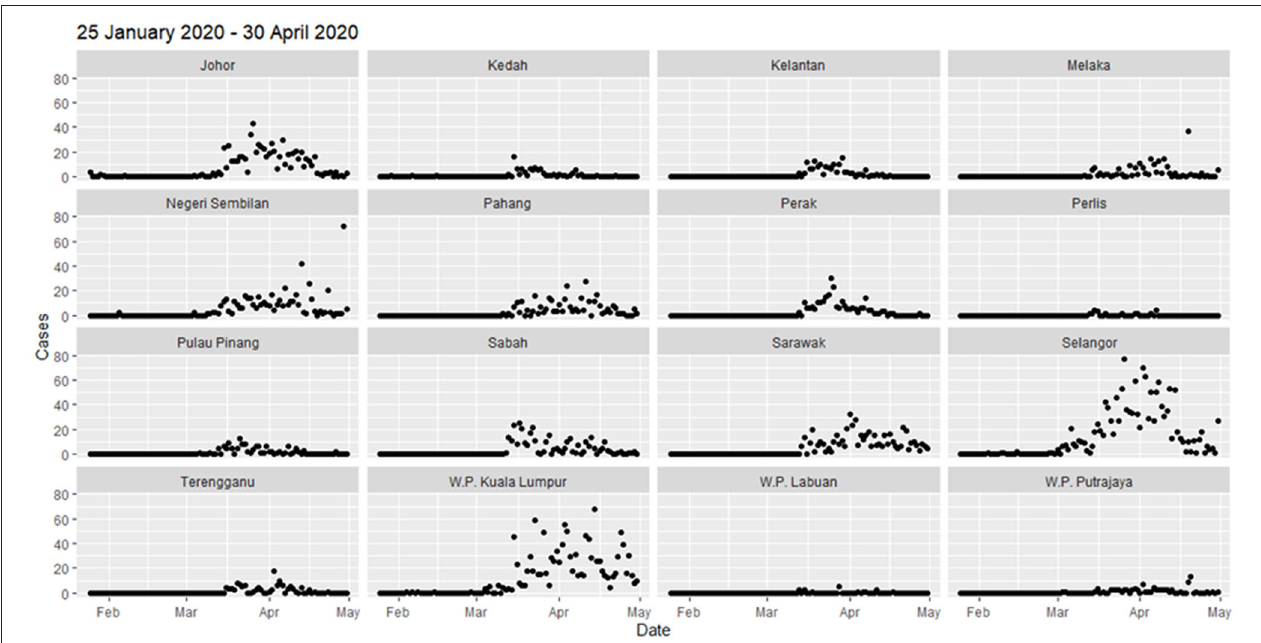
FIGURE 2 | Total COVID-19 new cases by state from January 25, 2020 to April 30, 2020.